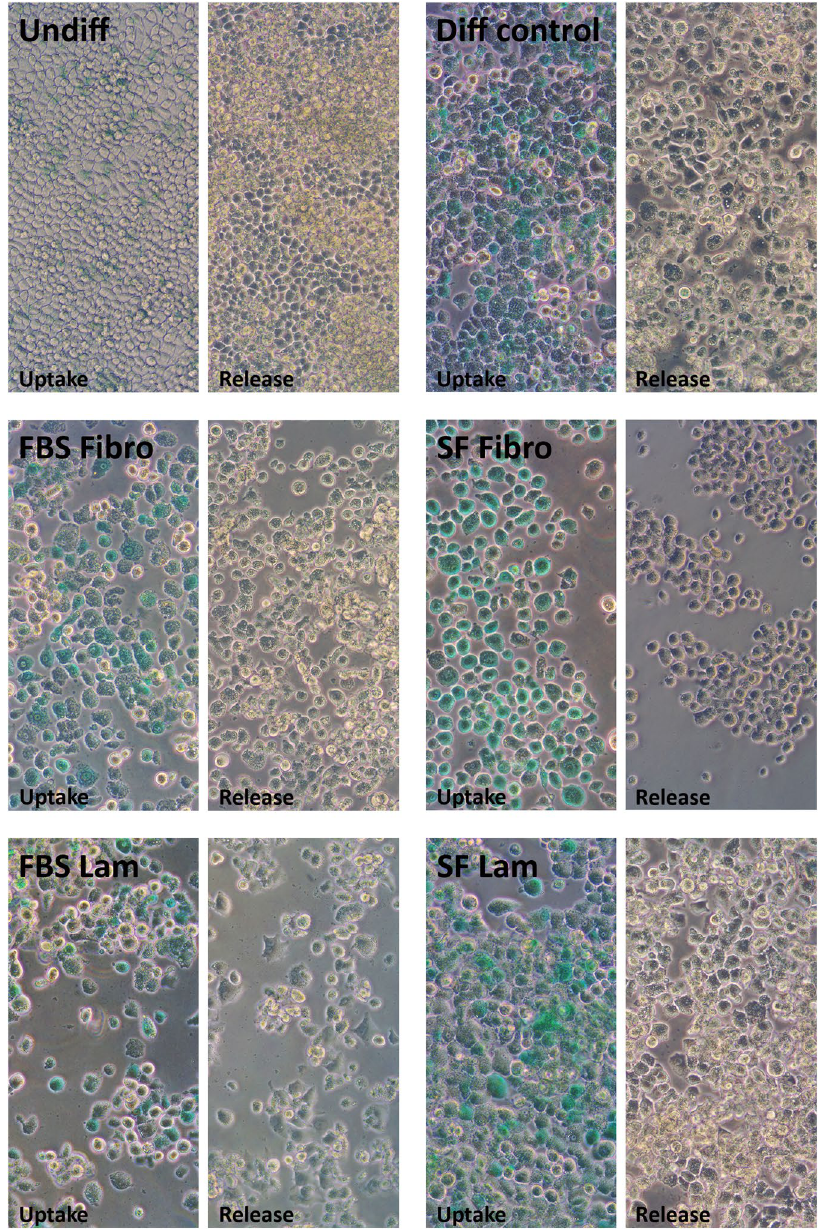
Figure 7. Indocyanine green uptake and release in undifferentiated AR42J-B13 cells and cells subjected to differentiation-inducing conditions on day 5, as a measure of hepatocyte functionality. Undiff - undifferentiated cells; Diff control - differentiation control, with FBS, on plastic; FBS Fibro - differentiation medium, with FBS, on fibronectin; SF Fibro - differentiation medium, serum-free, on fibronectin; FBS Lam - differentiation medium, with FBS, on laminin; SF Lam - differentiation medium, serum-free, on